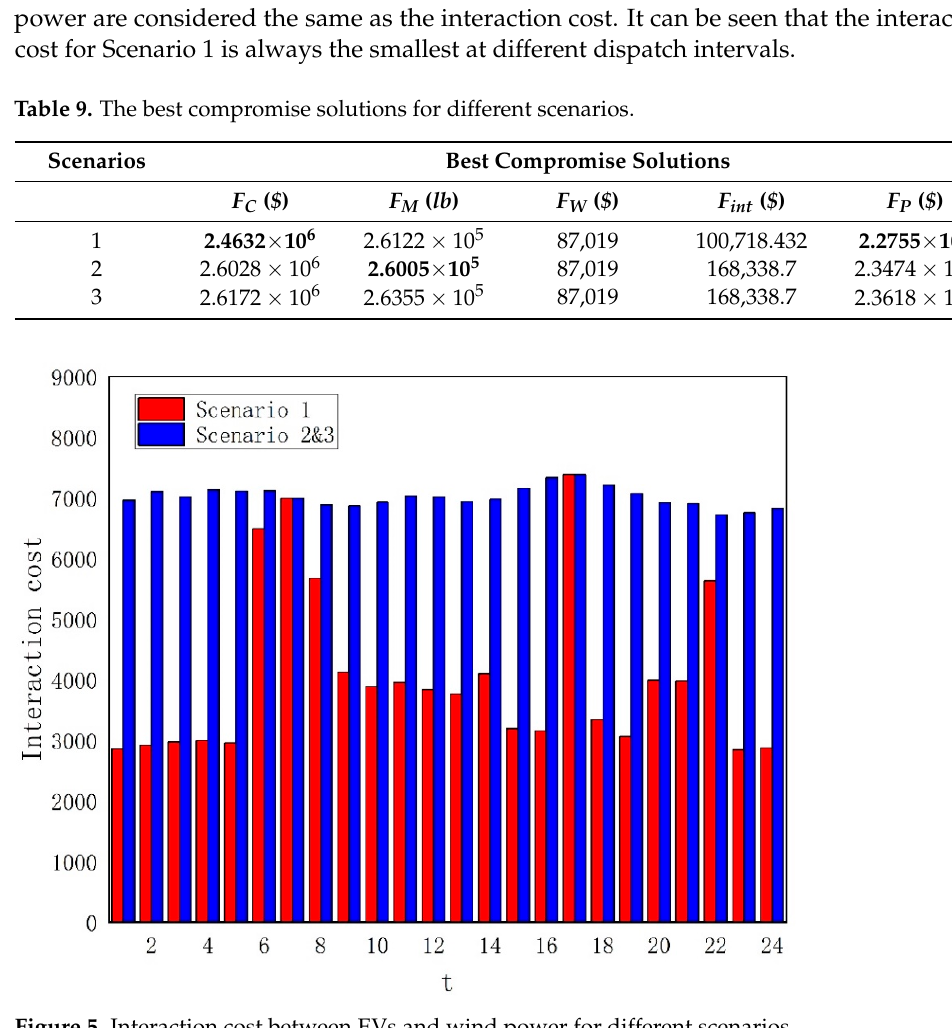
Figure 5. Interaction cost between EVs and wind power for different